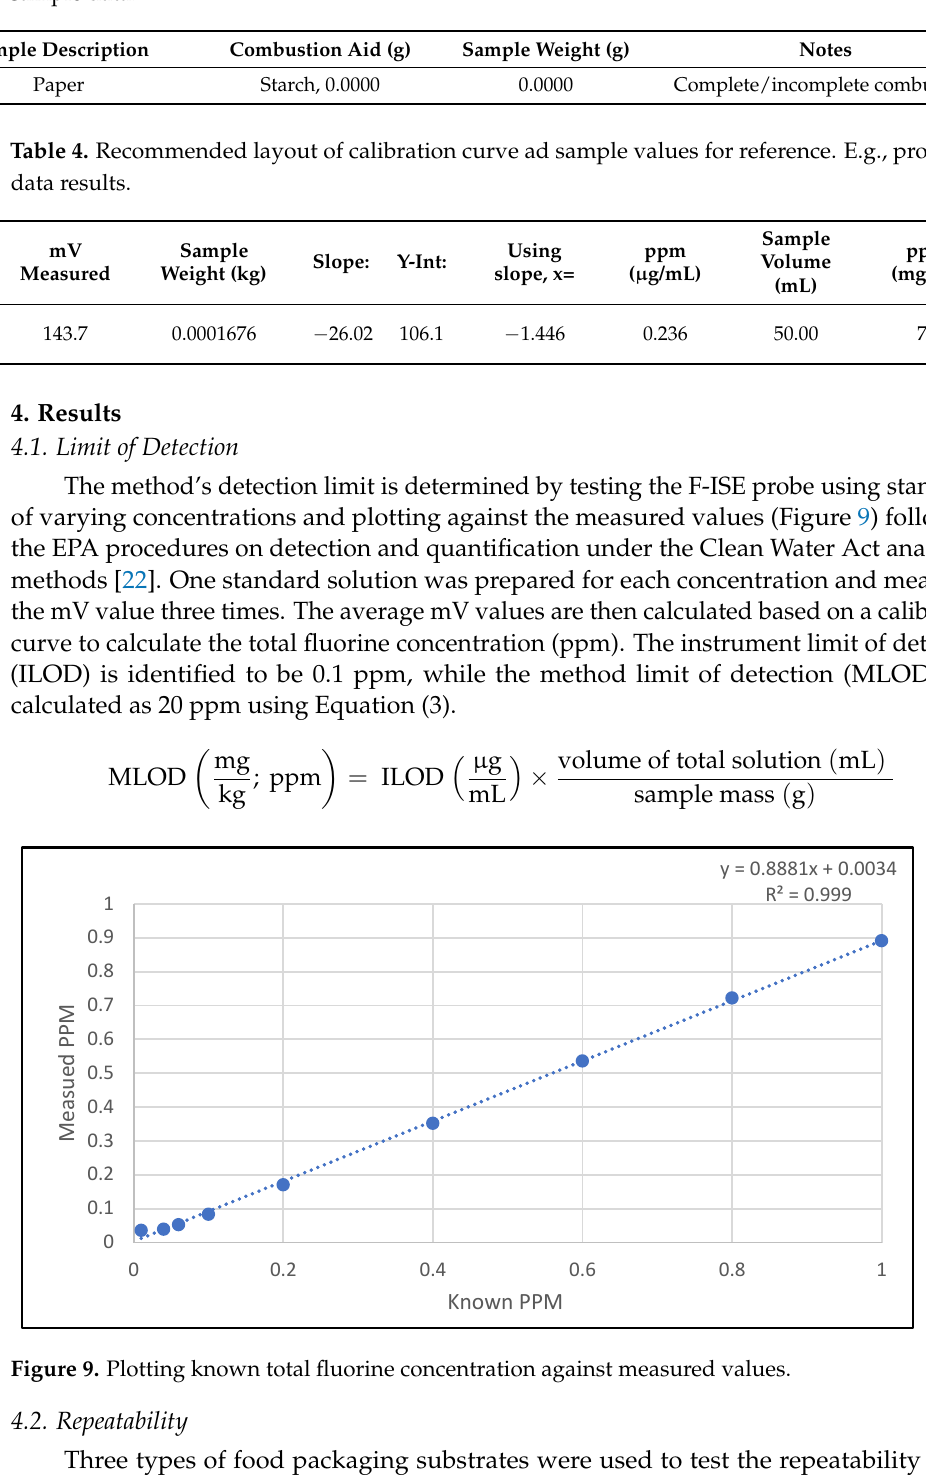
Table 5. Total fluorine measurements for repeatability evaluation.